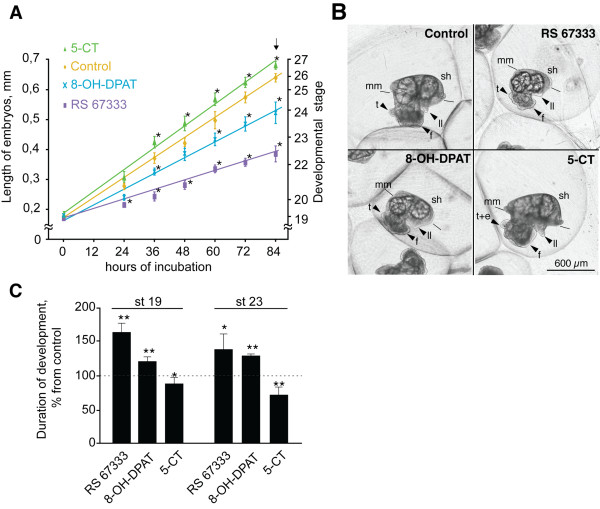
Effects of different agonists of 5-HT receptors on embryonic development of H. trivolvis. (A) The length of embryos during the development under control conditions (control, n = 80) and after incubation with 5-HT4R agonist RS67333 (2.5 μM, n = 80), 5-HT7R agonist 8-OH-DPAT (5 μM, n = 80) and 5-HT1R agonist 5-CT (1 μM, n = 80). Development is significantly retarded after RS67333 and 8-OH-DPAT, and accelerated after 5-CT treatment. Linear fitting slope coefficient (k) is 0.068 for control (R2 = 0.99), 0.031 for RS67333 (R2 = 0.98), 0.052 for 8-OH-DPAT (R2 = 0.99), and 0.075 for 5-CT (R2 = 0.99). (B) Overview of representative larvae after 84 h of incubation in the above mentioned drugs, equal magnification. The size of embryos strongly corresponds to certain developmental stages. At the time when the control animal is in the end of metamorphosis and represents a miniature snail, the embryos incubated with RS67333 and 8-OH-DPAT are still at the premetamorphic stage. On the contrary, the embryo incubated with 5-CT reaches the postmetamorphic adult-like stage and is bigger than the control. (See also supplementary materials Movies 1 to 3). f – foot, ll – lung lobe, mm – mantle margin, t – tentacle, e – eye, sh – shell. (C) Incubation with RS67333 (2.5 μM) and 8-OH-DPAT (5 μM) results in significant increase of both total duration of development and duration of metamorphosis. Retardation effect of RS67333 is more pronounced, when treatment starts at stage 19. Incubation with 5-CT (1 μM) reduces developmental time and duration of metamorphosis with the strongest effect at stage 23 (n = 60 for each group). Data are shown as mean ± s.d. (*, p <0.05; **, p <0.01).